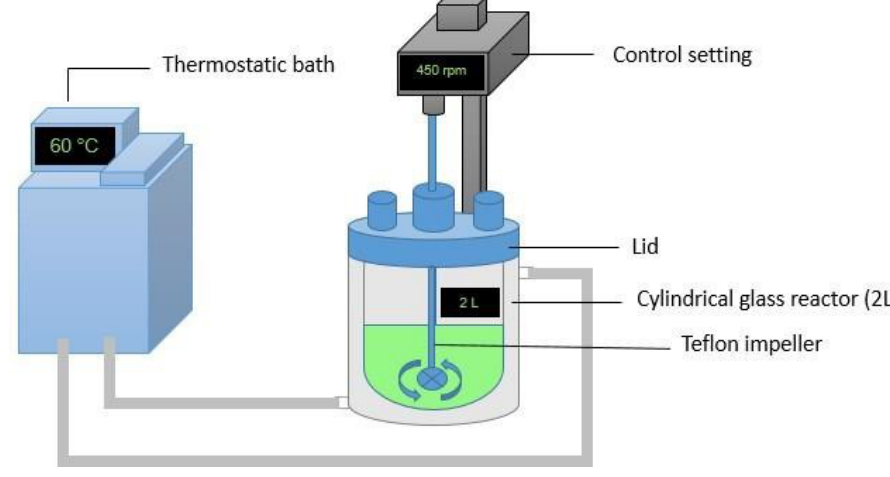
Figure 1. A schematic diagram of the agitated leaching reactor used in this study.